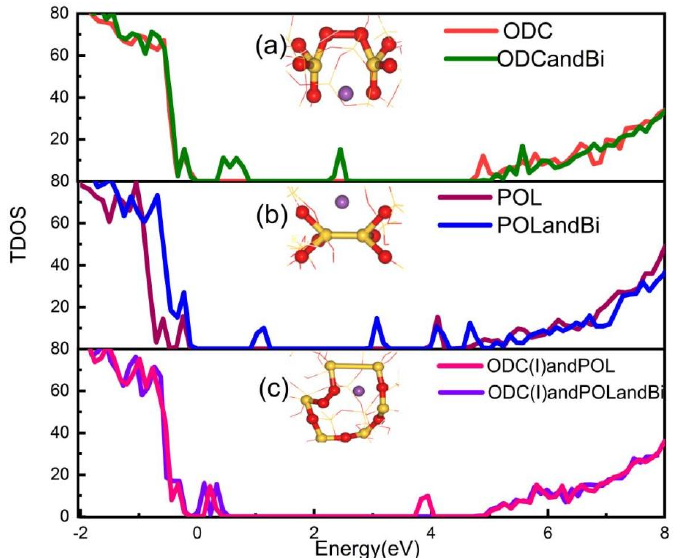
Figure 3. ( a ) Red line represents the density of states diagram of Oxygen vacancy defect ODC(I) of Undoped silica fiber, and blue line represents the density of states diagram of bismuth-doped silica fiber of Oxygen vacancy defect ODC(I). ( b )wine red line represents the density of states diagram of peroxy chain defect POL of Undoped silica fiber, and blue line represents the density of states diagram of peroxy chain defect POL of bismuth-doped silica fiber. ( c ) pink line represents the density of states diagram of undoped silica fiber with oxygen vacancy defect ODC(I) and peroxy bond defect (POL) presence in the ortho-position of the six-membered ring, and purple line represents the density of states diagram of bismuth-doped silica fiber with oxygen vacancy defect ODC(I) and peroxy bond defect (POL) presence in the ortho-position of the six-membered ring.